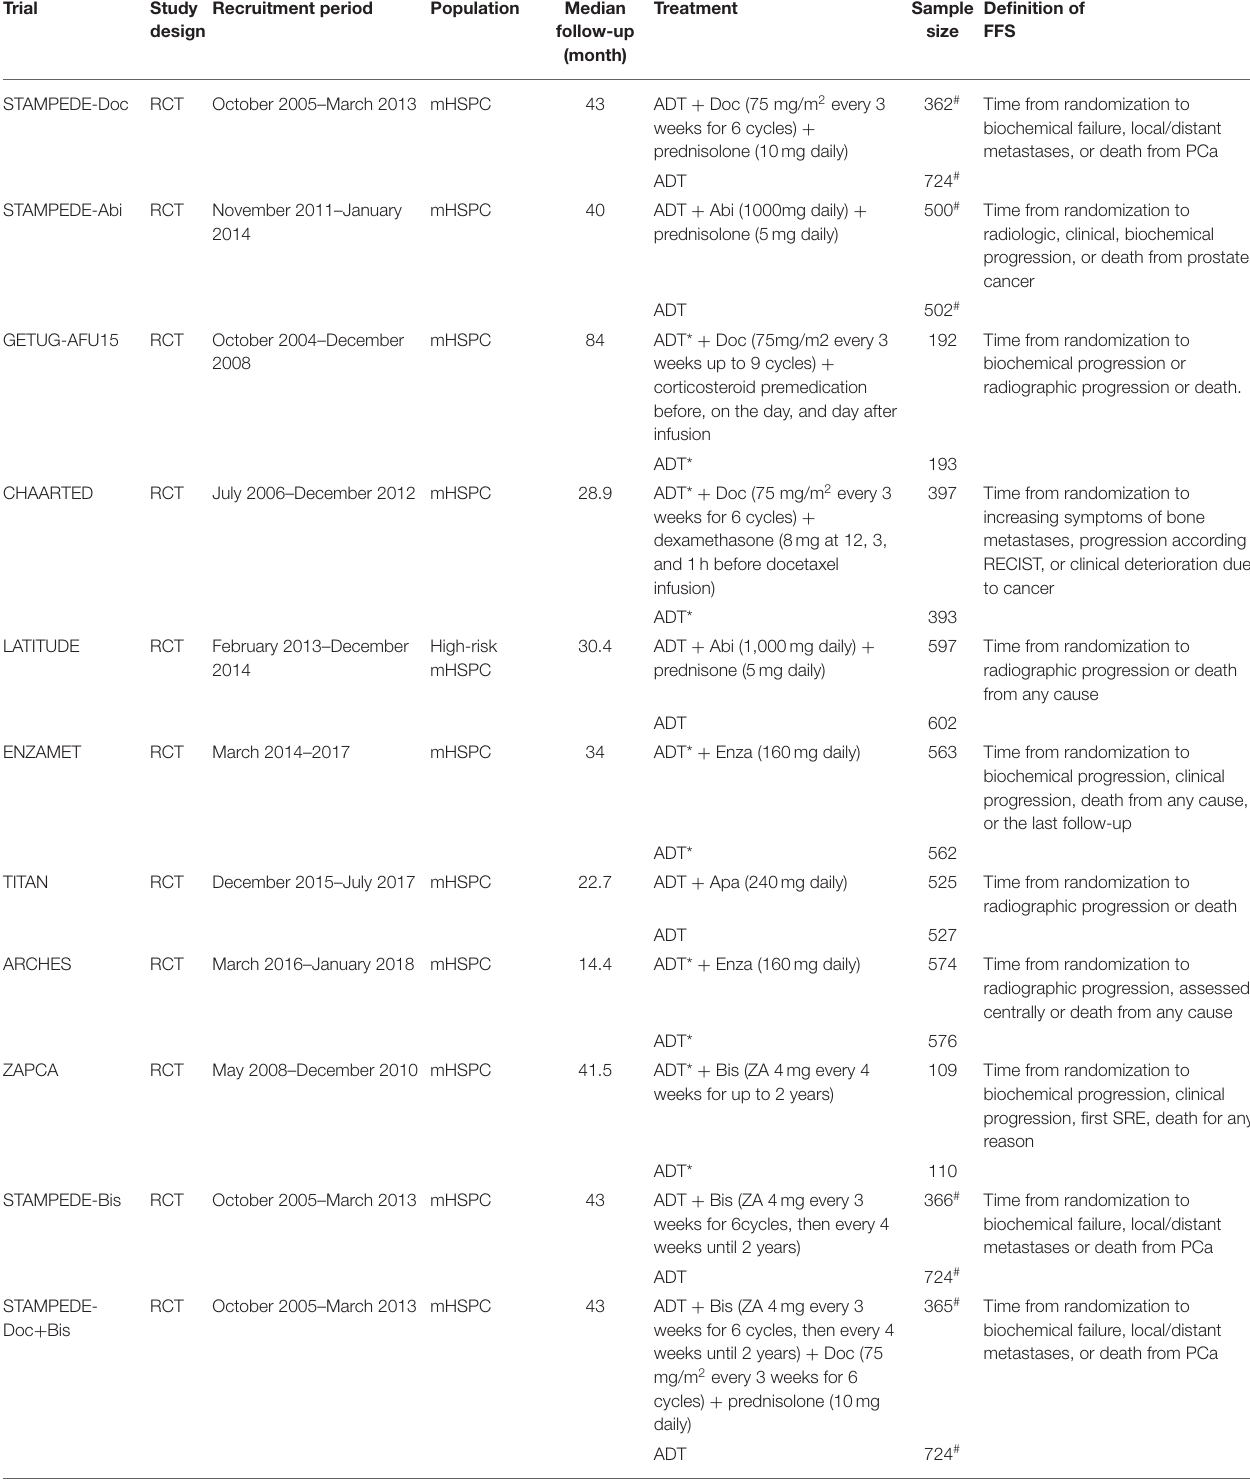
TABLE 1 | Characteristics of the included